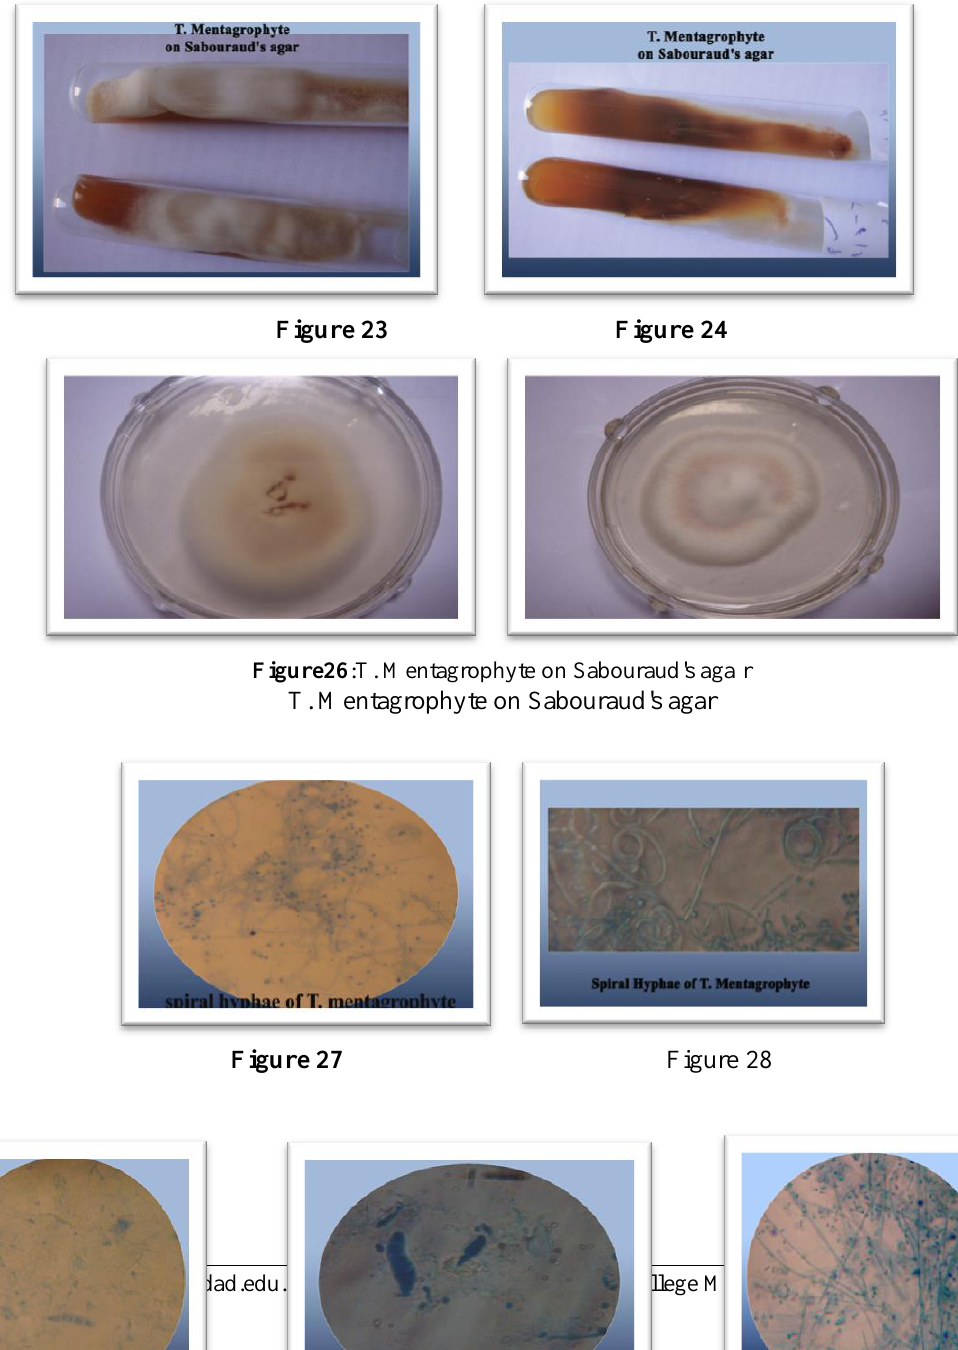
Figure 24: Germ Tube Test of Candida Albicans Figure 25 : chlamydospores of candida albicans